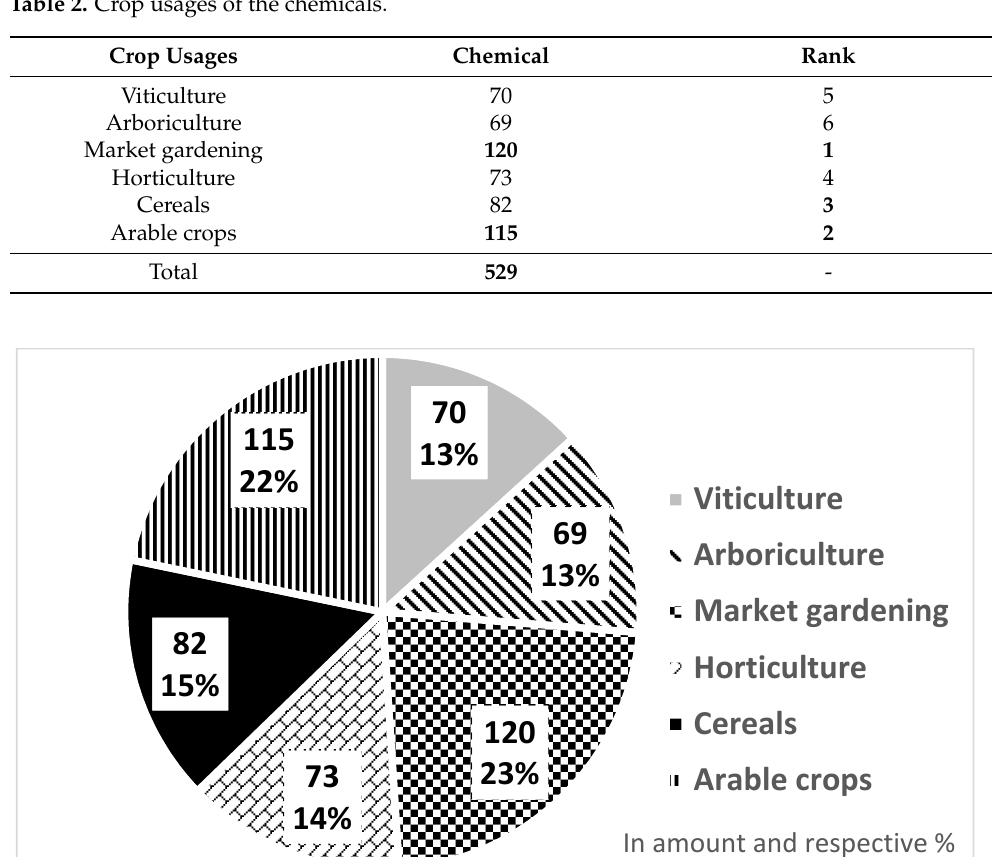
Table 3. Comparison matrix of the chemicals between functions and crop usages.